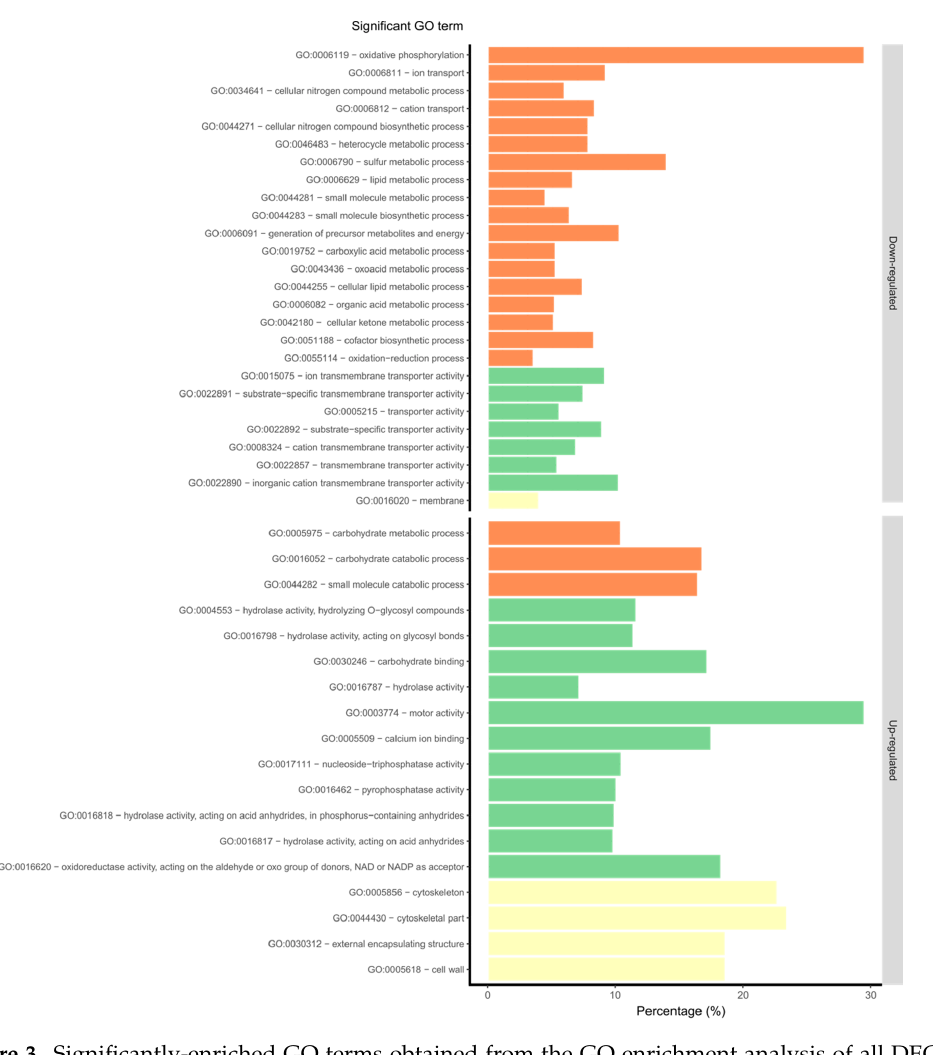
Figure 3. Significantly-enriched GO terms obtained from the GO enrichment analysis of all DEGs. The three main GO categories represent biological processes (orange), molecular functions (green), and cellular components (yellow). For each GO term, the percentage of up- and down-regulated genes compared to the number of genes in the genome associated with the same GO term is represented. Significant GO terms associated with DEGs were ordered by increasing FDR value.